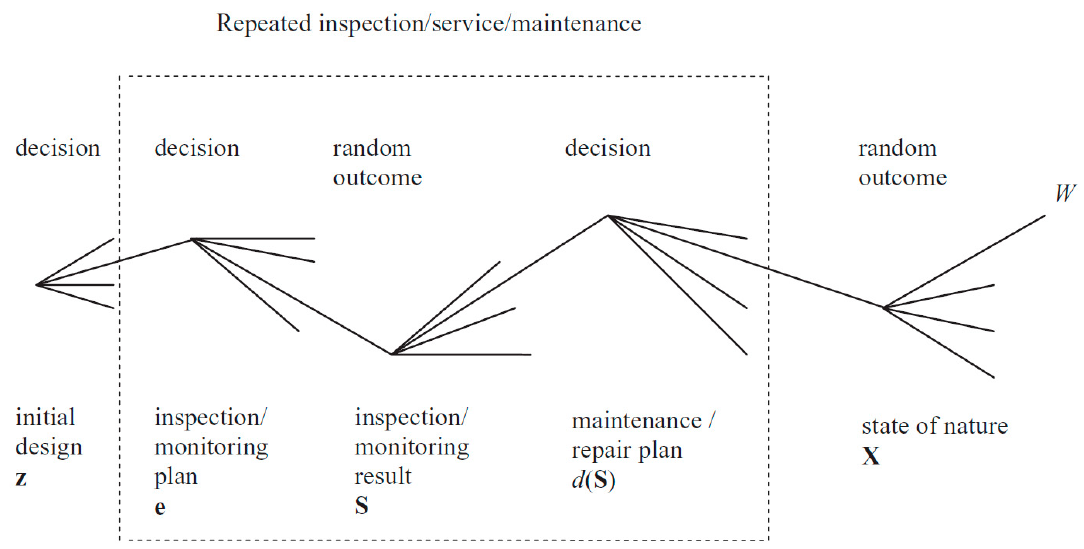
Figure 4. Framework of a risk based Bayesian decision model for optimal O&M planning. Reproduced with permission of John Wiley and Sons [15] .